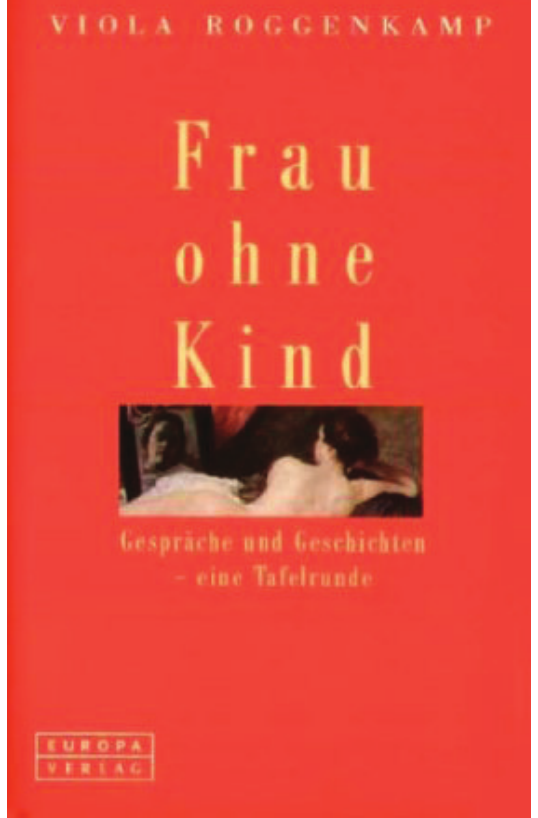
Figure 33. Book cover: Woman without child: Conversations and Stories – A Symposium , published 2004; with kind permission of Frauke